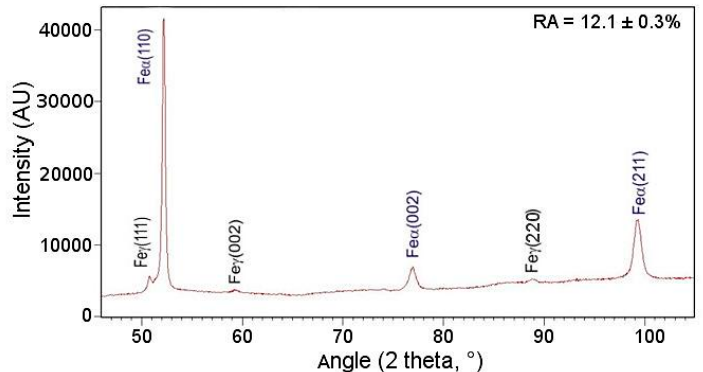
Figure 5. X-ray diffraction pattern of investigated steel in the initial state.